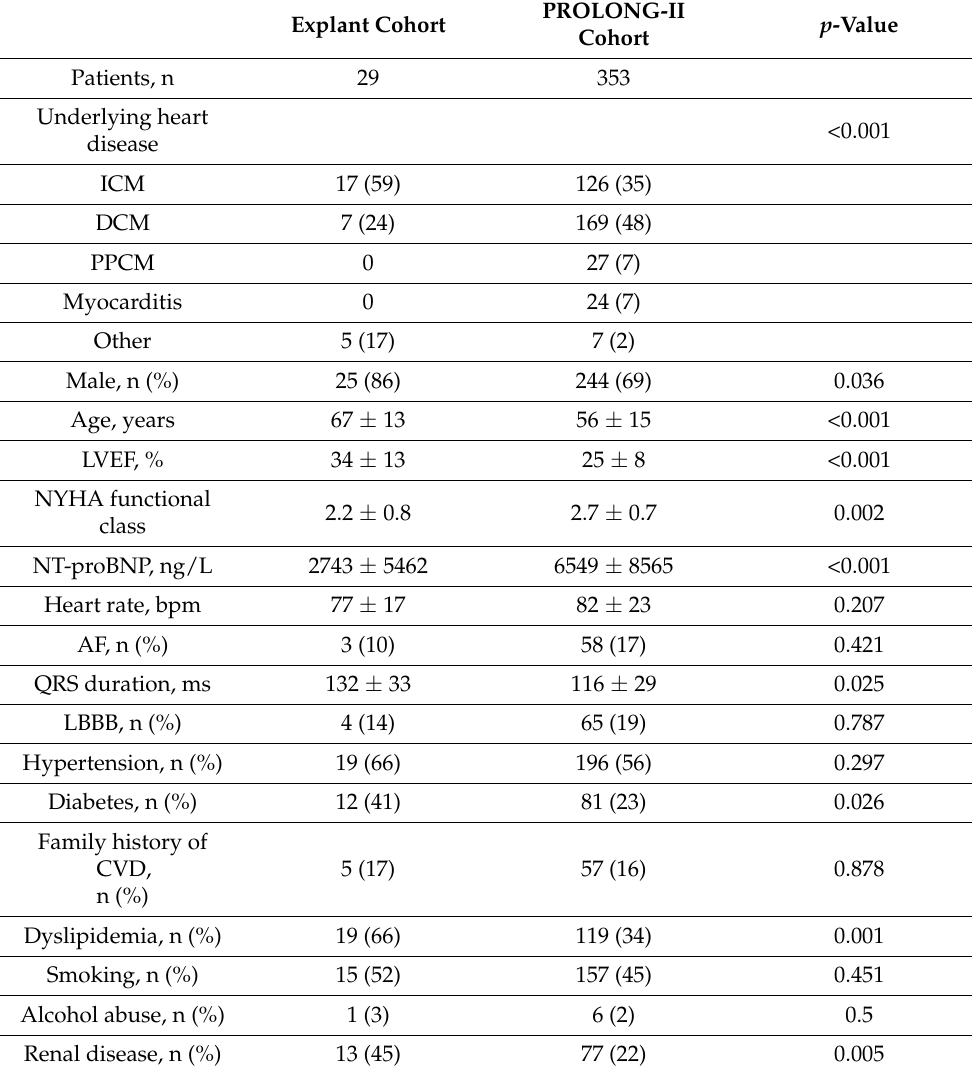
Table 2. Baseline characteristics of patients with an explanted ICD versus patients with newly diagnosed HFrEF (PROLONG-II cohort). PROLONG-II p -Value Explant Cohort Cohort Patients, n 29 353 Underlying heart disease